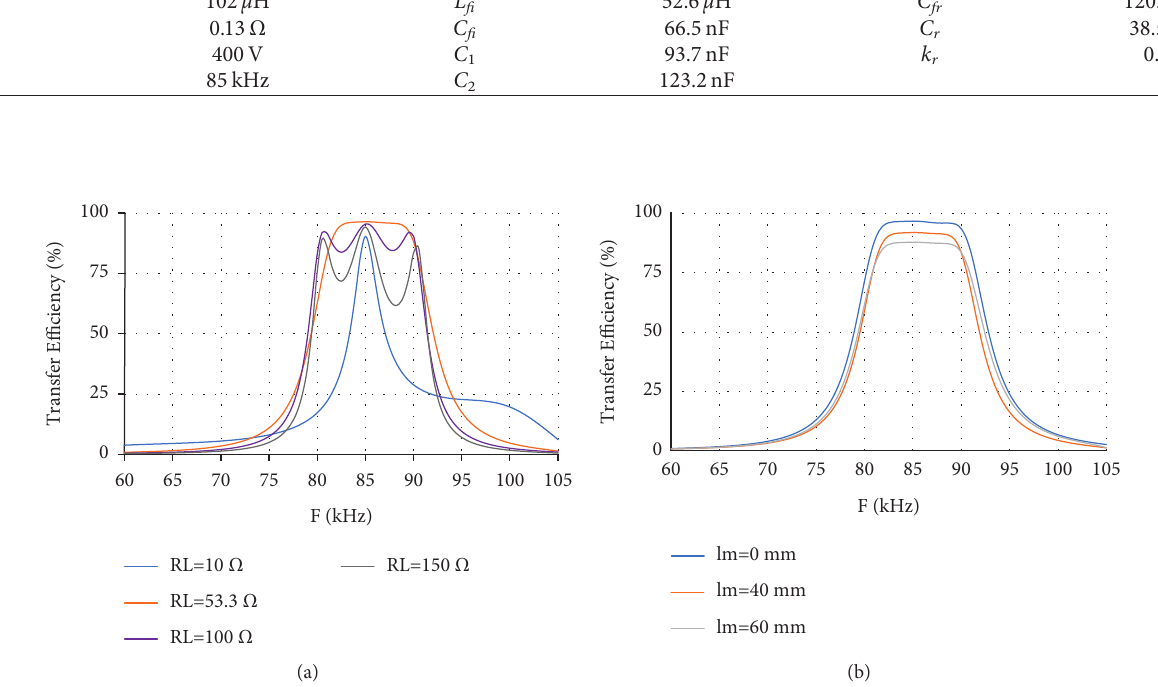
� 0 mm and R m L is variation. (b) l m is variation and R L